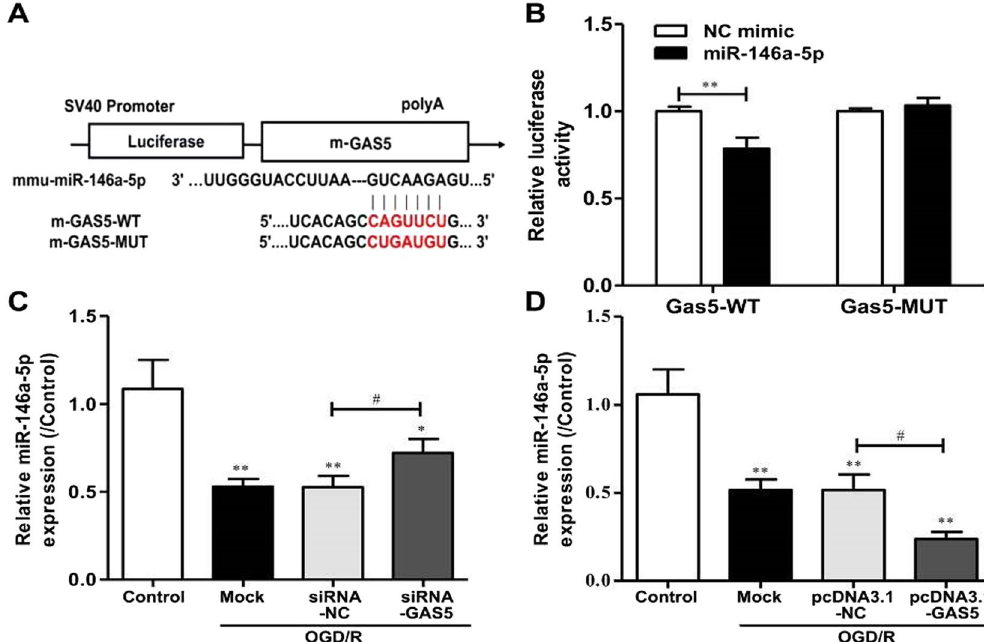
Figure 6. GAS5 is a target of miR-146a-5p and negatively regulates its expression. ( A ) The predicted position of miR-146a-5p binding site on the GAS5 transcript. ( B ) The wide type (GAS5-WT) and mutant GAS5 (GAS5- MUT) were co-transfected with miR-146a-5p mimic or control mimic (NC mimic) into BV2 microglia cells and luciferase activity was detected. ( C ) RT-PCR for the expression of miR-146a-5p in microglia after transfection with si-GAS5/siRNA-NC in the presence of OGD/R exposure. ( D ) RT-PCR for the expression of miR-146a-5p in BV2 microglia cells after transfection with pcDNA3.1-GAS5/pcDNA3.1-NC in the presence of OGD/R exposure. * P < 0.05, ** P < 0.01 versus Control; # P < 0.05, ## P <